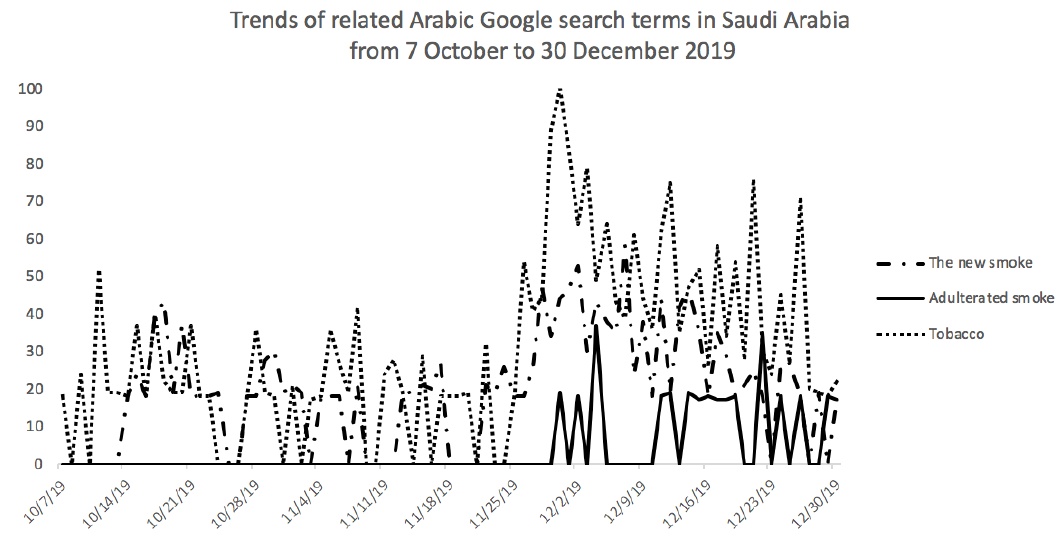
Figure 2. The numbers in the vertical axis represent search interest. A value of 100 is the peak popularity for the search term and a value of 0 means that there was not enough data for the search term (data accessed 6 January, 2020).